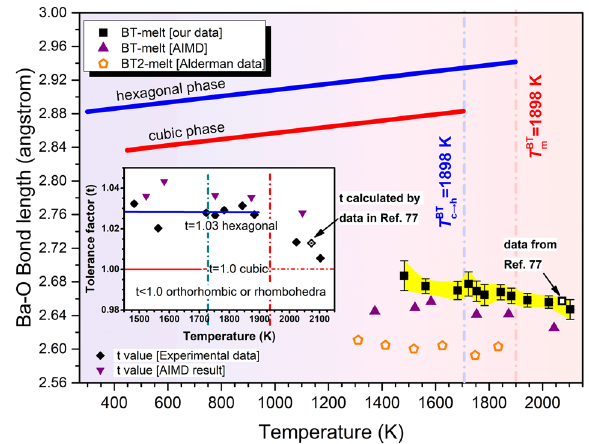
Fig. 8 Structural evolution of Ba – O polyhedra in BT melt during cooling. The variation of Ba – O mean bond length in BT melt, obtained from peak- differentiation of T ( r ) or calculated based on AIMD ensembles, as a function of temperature. The error bars correspond to the standard deviation derived from Gaussian fi tting. Open square is the result from ref. 77 . Data for BT2 melt 47 and two crystalline BT phases 61,62 are also included for comparison. The inset fi gure shows the tolerance